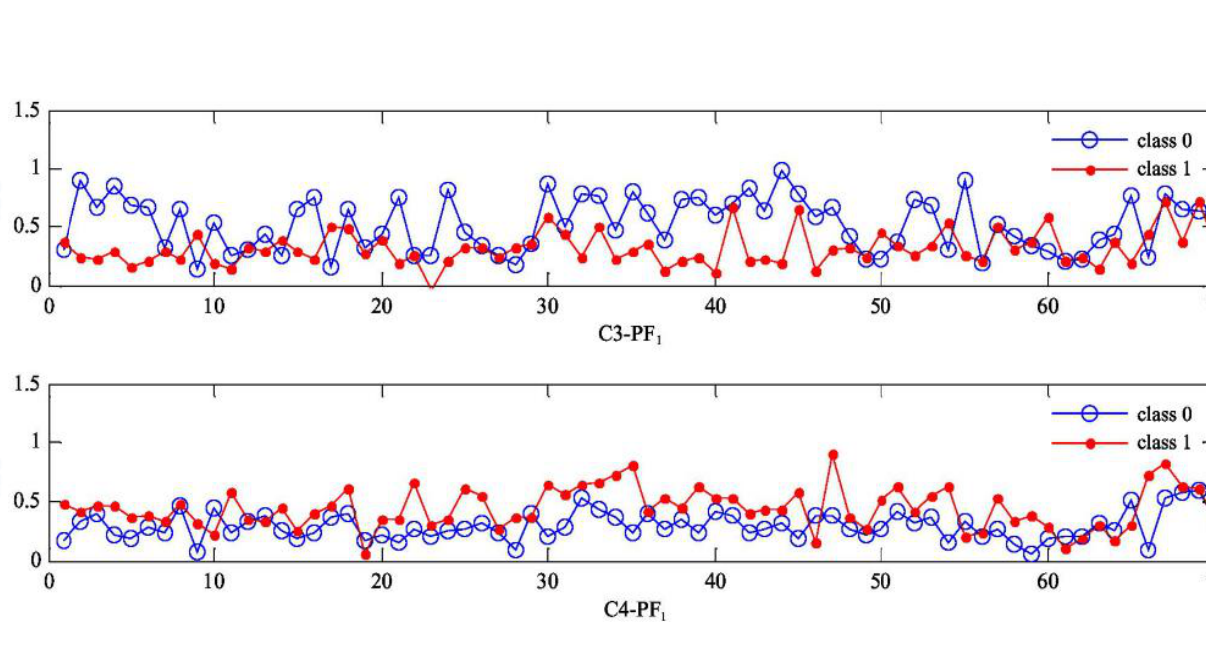
Figure 5. Multiscale fuzzy entropy distribution